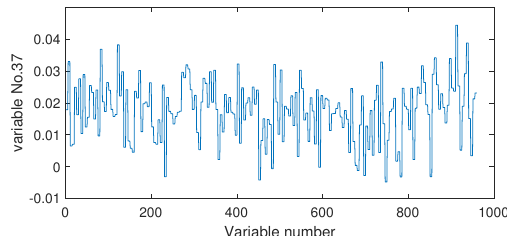
Figure 15. The variable trend (No. 37) when fault F10 occurs.